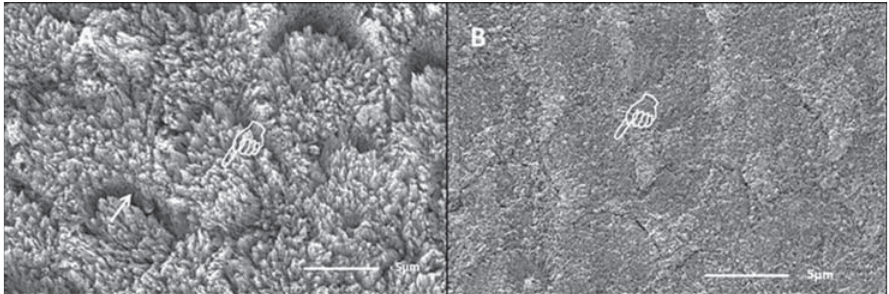
Figure 4- Scanning eletron microscopy micrographs of the 35% phosphoric acid etching (A) and the self-etch Futurabond NR (B) patterns. Selective demineralization of enamel prism periphery can be observed (white arrow, type 2 pattern). Prism (cid:18)(cid:7)(cid:13)(cid:2)(cid:16)(cid:10)’(cid:2)(cid:13)(cid:2)(cid:10)(cid:5)(cid:8)(cid:16)(cid:7)(cid:10)(cid:16)(cid:12)(cid:30)(cid:2)(cid:13)(cid:29)(cid:18)(cid:14)(cid:5)(cid:8)(cid:8)"(cid:10)(cid:15)(cid:2)!(cid:14)(cid:6)(cid:2)(cid:13)(cid:5)(cid:8)(cid:14)*(cid:2)(cid:15)(cid:10)(cid:14)(cid:6)(cid:18)(cid:13)(cid:2)(cid:5)(cid:16)(cid:14)(cid:6)(cid:17)(cid:10)(cid:3)(cid:4)(cid:2)(cid:10)^(cid:7)(cid:6)(cid:15)(cid:14)(cid:6)(cid:17)(cid:10)(cid:5)(cid:13)(cid:2)(cid:5)(cid:10)<(cid:30)(cid:7)(cid:14)(cid:6)(cid:3)(cid:2)(cid:13)?(cid:20)(cid:10)<(cid:21)?(cid:10)(cid:10)(cid:27)(cid:2)!(cid:14)(cid:6)(cid:2)(cid:13)(cid:5)(cid:8)(cid:14)*(cid:5)(cid:3)(cid:14)(cid:7)(cid:6)(cid:10)(cid:18)(cid:13)(cid:2)(cid:5)(cid:3)(cid:2)(cid:15)(cid:10)^"(cid:10)(cid:16)(cid:2)(cid:8)\(cid:22)(cid:2)(cid:3)(cid:18)(cid:4)(cid:10) adhesive resembles the type 2 pattern, prism peripheries were demineralized more deeply than prism cores. A shallower